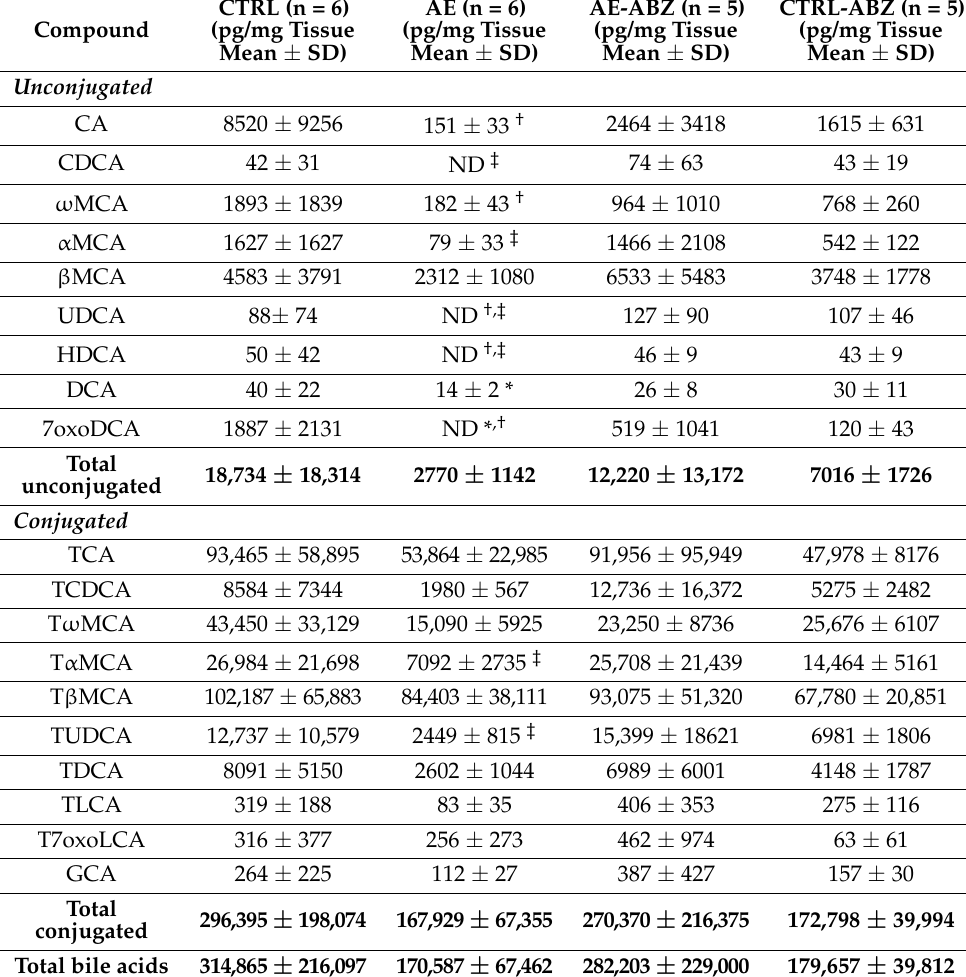
Table 2. Effects of E. multilocularis infection and ABZ treatment on bile acids in liver tissue of mice. The liver samples were collected from non-infected control (CTRL, n = 6), E. multilocularis -infected (AE, n = 6), E. multilocularis -infected and ABZ-treated (AE-ABZ, n = 5, one outlier with aberrant concentrations was removed), and non-infected and ABZ-treated control mice (CTRL-ABZ, n = 5, one outlier with aberrant concentrations was removed),). * p < 0.05 AE vs. CRTL, † p < 0.05 AE vs. CTRL-ABZ, and ‡ p < 0.05 AE vs. AE-ABZ. Values are expressed as mean ± SD (pg/mg tissue). ND: Not-detected. CTRL (n = 6) AE (n = 6) AE-ABZ (n = 5) CTRL-ABZ (n = 5) Compound (pg/mg Tissue (pg/mg Tissue (pg/mg Tissue (pg/mg Tissue Mean ± SD) Mean ± SD) Mean ± SD) Mean ± SD) Unconjugated